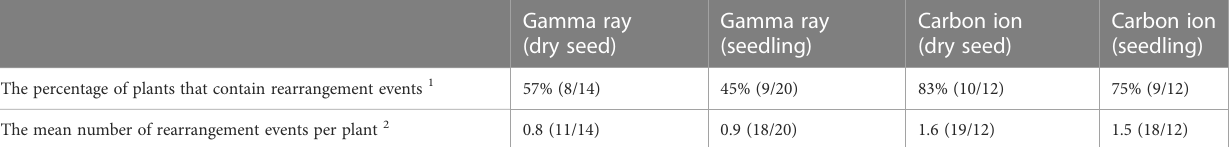
TABLE 2 Frequency of occurrence of rearrangement events per